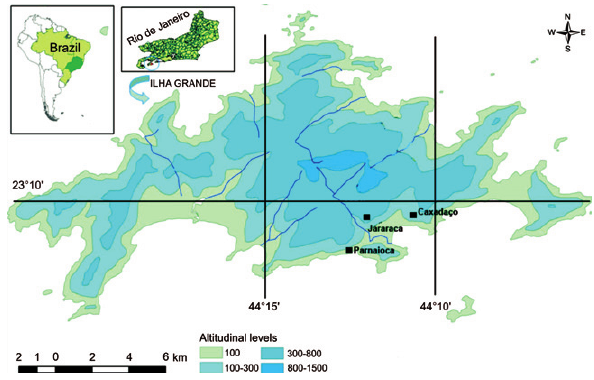
Figure 1. Location of Ilha Grande, in Angra dos Reis Municipality, state of Rio de Janeiro, Brazil, showing the Jararaca, Parnaioca, and Caxadaço trails. Map: Luiz E.M.